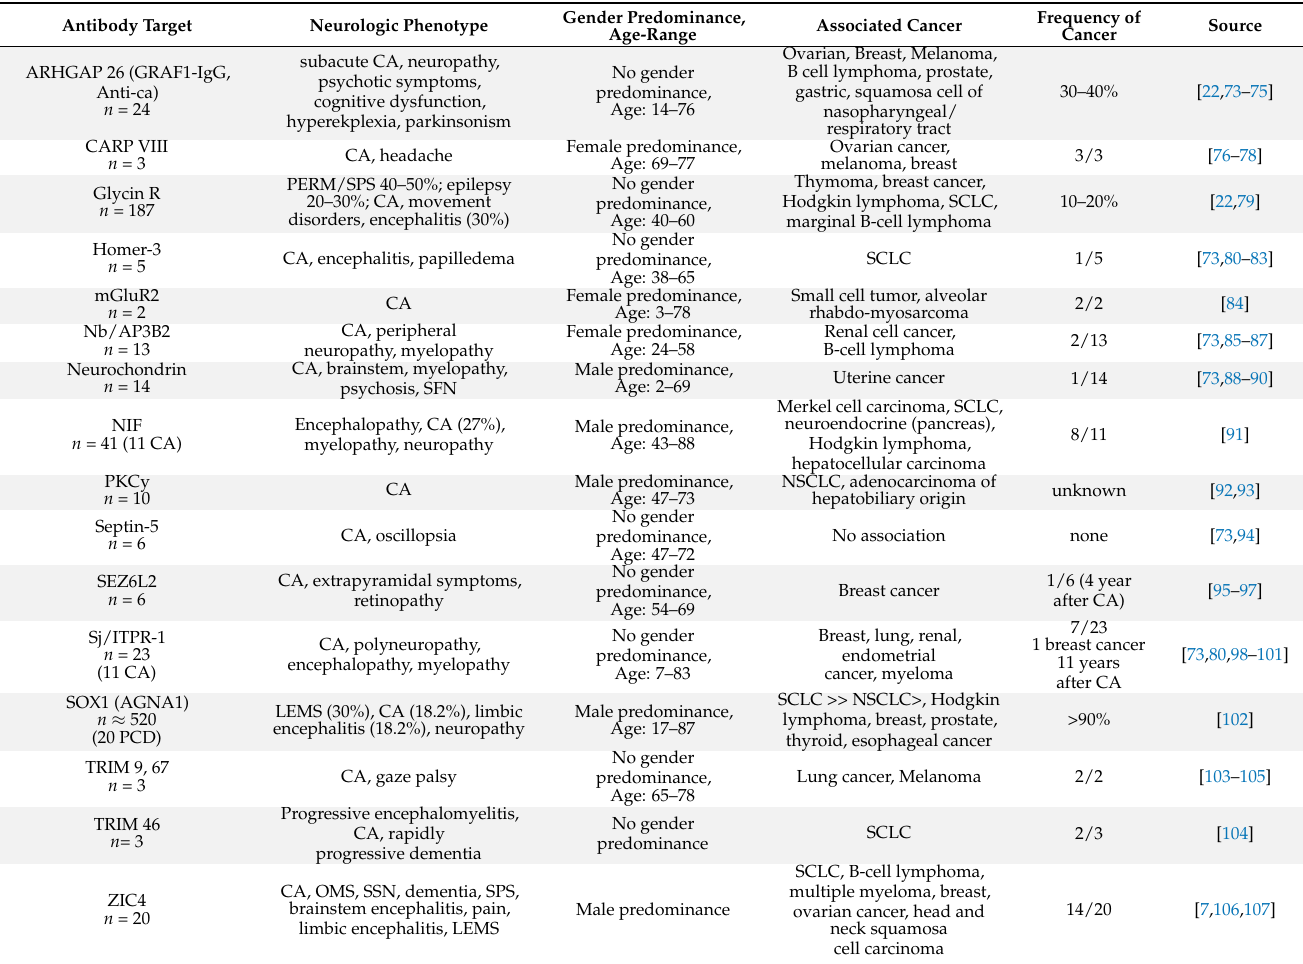
Table adopted from Mitoma et al. and Graus et al. [1,6]. Abbreviations: Ca/ARHGAP26 : Ca/Rho GTPase-activating protein, CARP VIII : carbonic anhydrase-related protein VIII; mGLUR2 : metabotropic glutamate receptor2; NB/AP3B2 : Nb/adaptor complex 3B2; NIF : Neuronal intermediate filament light chain; SEZ6L2 : seizure-related 6 homolog like 2; Sj/ITPR-1 : inositol 1,4,5-triphosphate receptor type 1; SOX-1 : sex-determining region Y-related high-mobility group box 1; TRIM 9, 67, 46 : tripartite motif-containing protein 9, 67, 46; ZIC4: zinc finger protein of the cerebellum 4 CA: cerebellar ataxia; LEMS: Lambert-Eaton myasthenic syndrome; NSCLC: non-small-cell lung cancer; OMS: opsoclonus myoclonus syndrome; PERM: progressive encephalomyelitis with rigidity and myoclonus; SCLC: small-cell lung